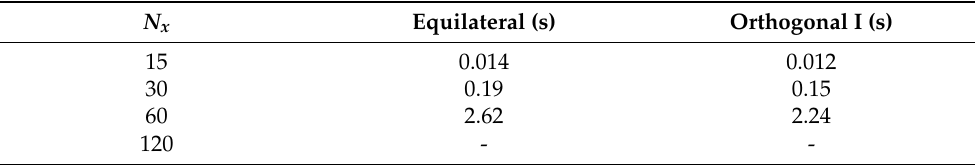
Table 4. Times needed for the ILU( k ) preconditioner’s computation.